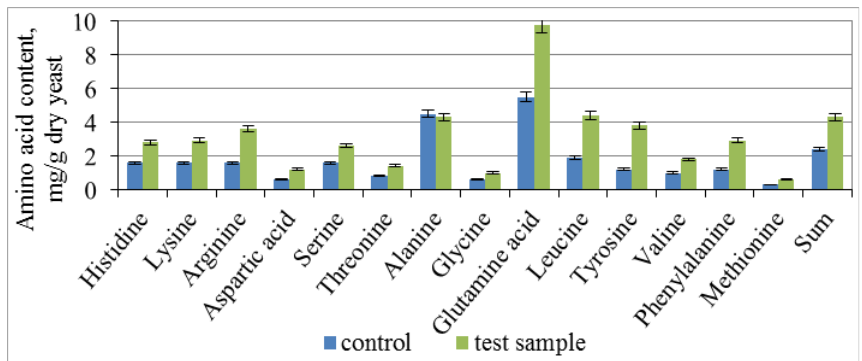
Figure 6. Effect of combined treatment of yeast with ultrasound and a mix of Krebs cycle acids on the yeast amino acid composition (the value ʺ Sum ʺ in the figure is represented as the sum value of amino acids× 10 1 ). The values with a statistically significant difference ≤ 0.05 are shown.